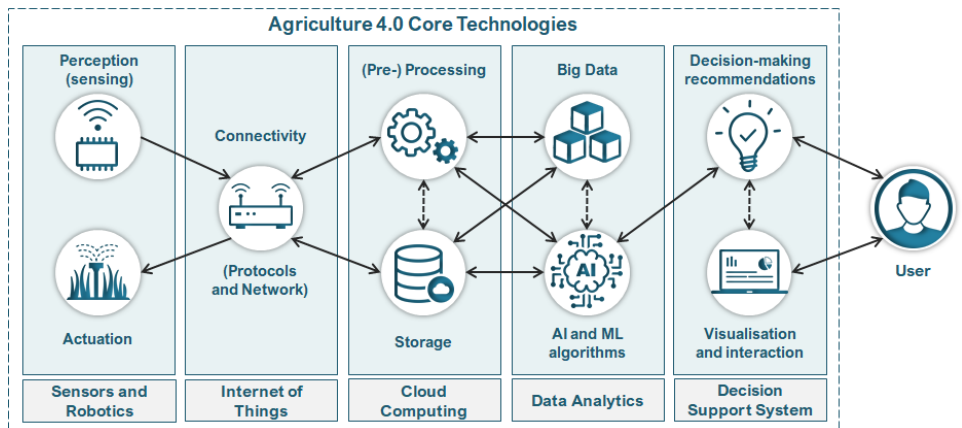
Figure 4. Data flow between the core technologies of the Agriculture 4.0 paradigm. Five main stages have been identified: sensor and robotics (includes perception and actuation functions, depending on the requirements of the system), Internet of Things (for data communication), cloud computing (for data storage and processing), data analytics (includes big data and AI-based methods for data analysis) and decision support system (for data visualisation, recommendation functions and user